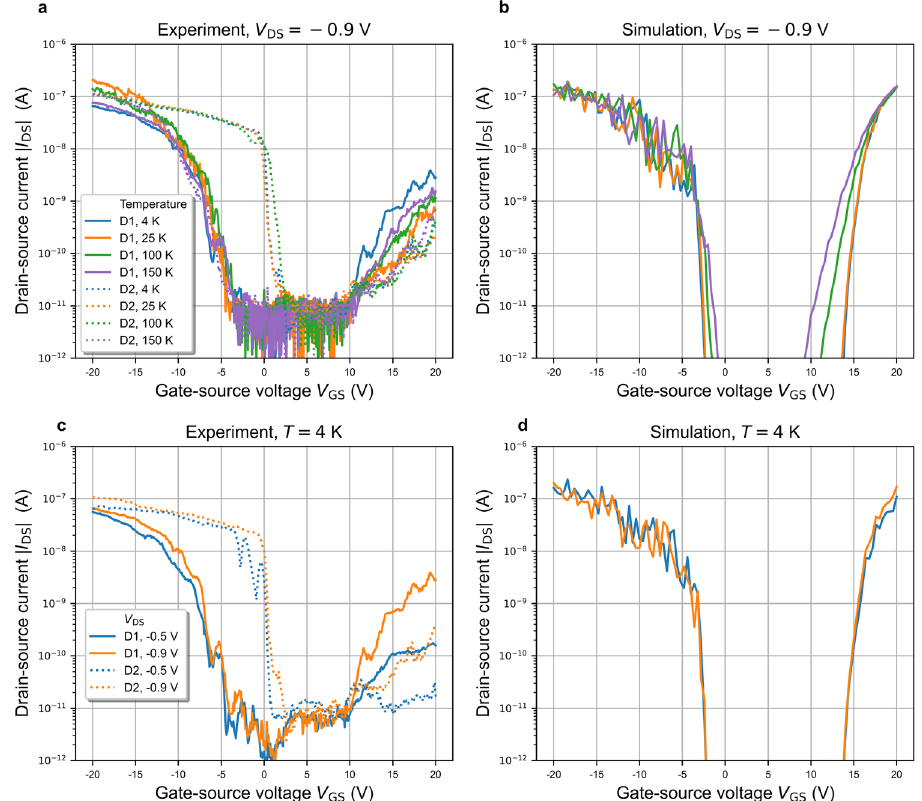
Fig. 6 Comparing experimental and simulated drain-source current I DS . a , b Experimental and simulated temperature dependence at fi xed drain-source voltage V DS = − 0.9 V plotted against the gate-source voltage V GS . Two devices are shown here: device 1 (D1) and device 2 (D2). The p-polar currents in the on-state ( V GS = − 20 V) agree well, while the n-polar ( V GS = 20 V) currents show large differences between experiment and simulation (about three orders of magnitude). c , d At constant temperature ( T = 4 K) and different drain-source voltages the p-polar on-state currents and the off-state regimes of experiment and theory agree again. However, our model cannot correctly reproduce the n-polar on-state currents. The results imply that the